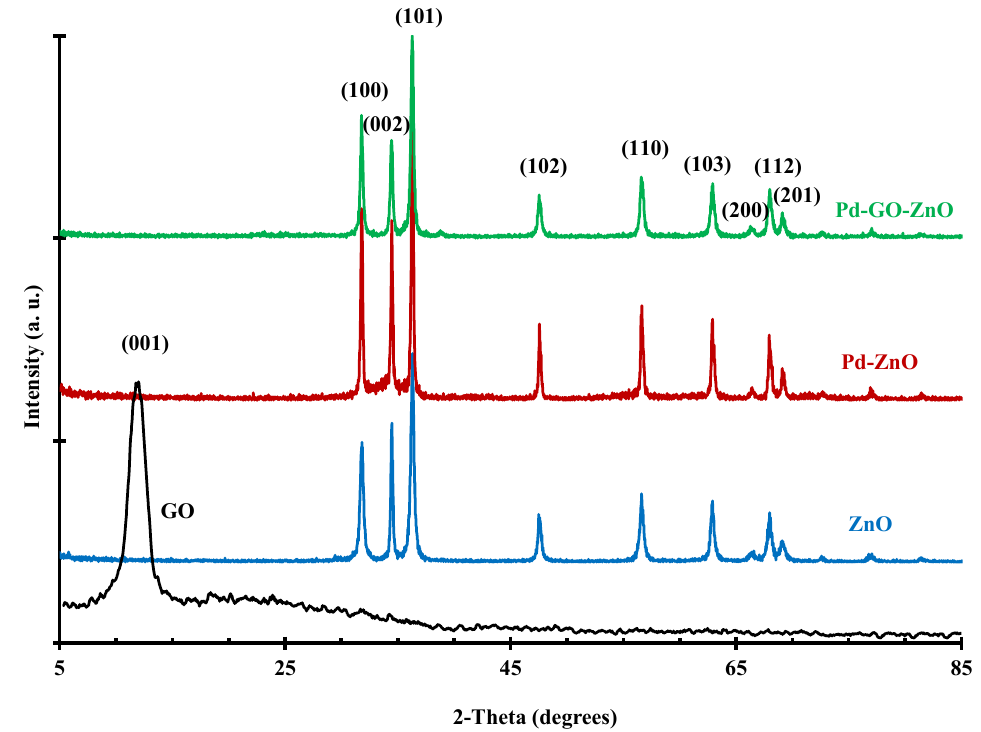
Figure 3. Powder XRD patterns of the GO, ZnO, Pd ‐ ZnO and Pd ‐ GO ‐ ZnO materials.